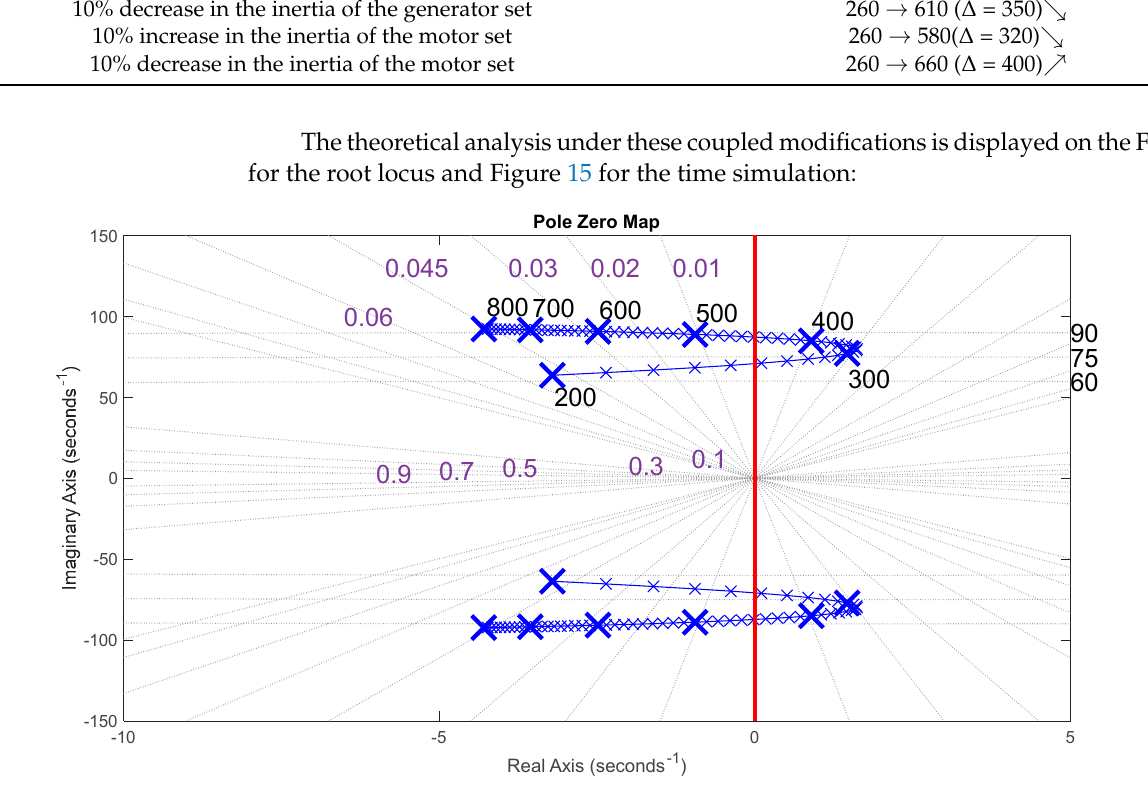
Figure 14. Small-signal model-based root locus analysis for coupled parametric modifications with a bandwidth of 1 Hz for the generator speed control and with coupled modifications of electric and mechanical parameters.